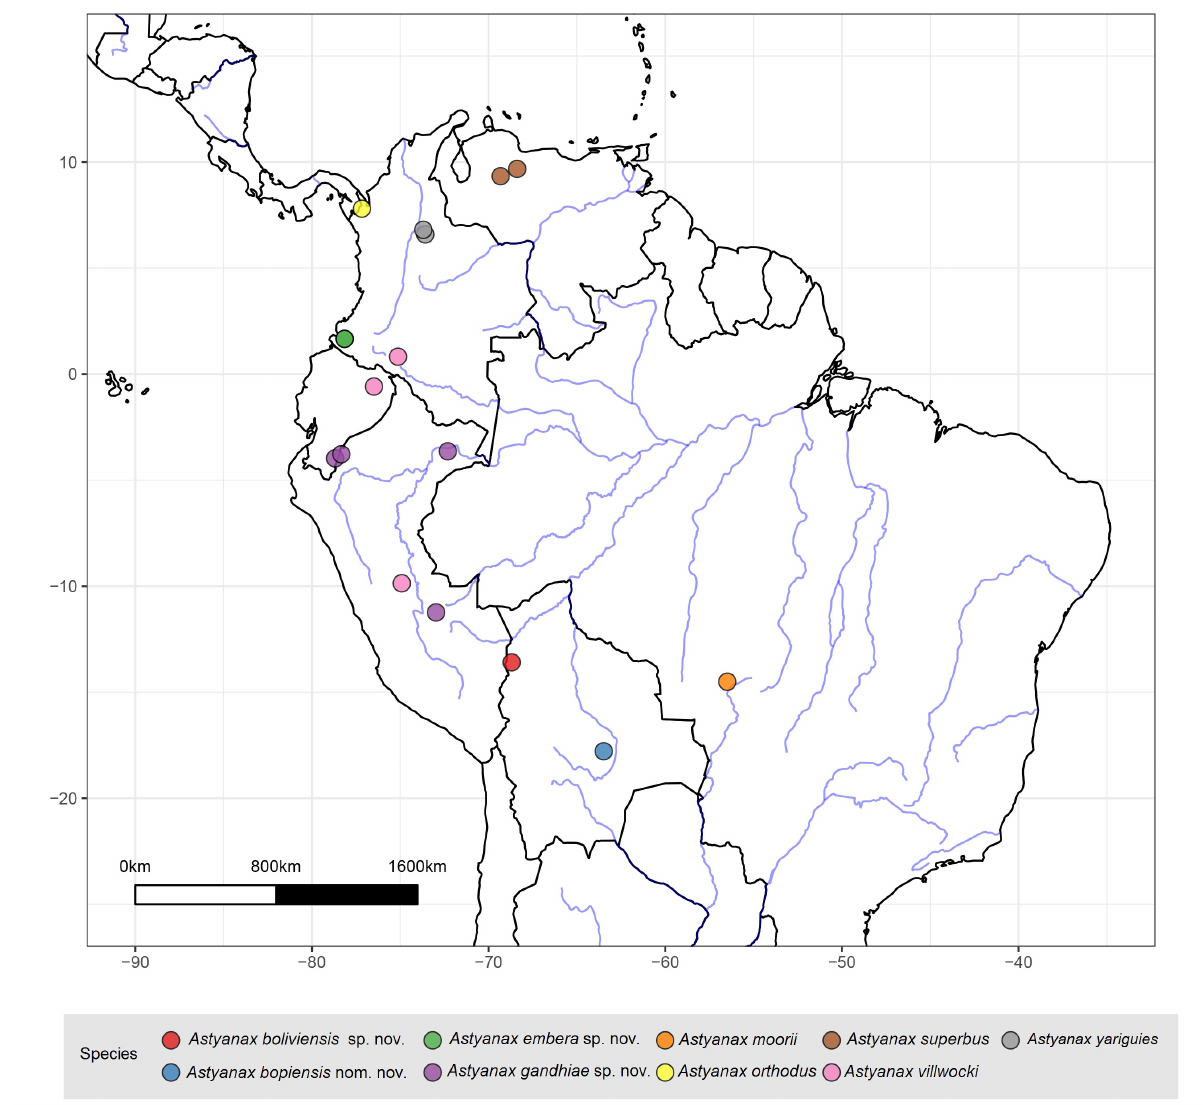
Fig. 4. Distribution of species of the Astyanax orthodus species-group (symbol includes